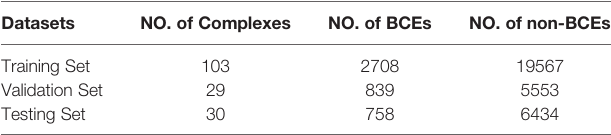
TABLE 1 | Summary of